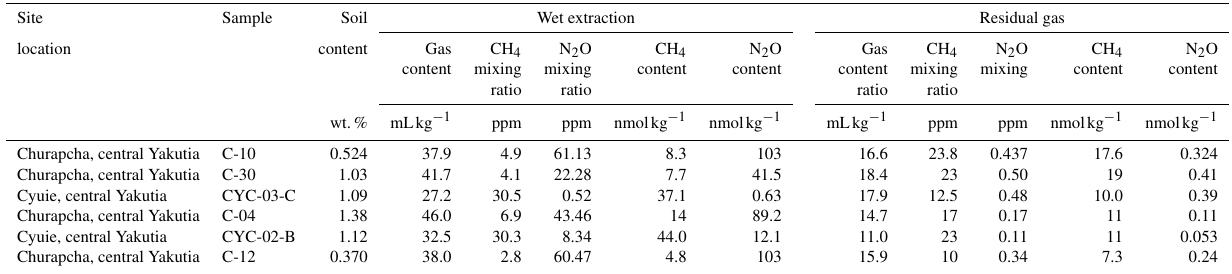
Table A2. Comparison of results from extracted gas from the conventional wet extraction method and the residual gas in ice after three wet extractions. The residual gas was extracted by a needle crusher (see Sect. 3.4 for details of the